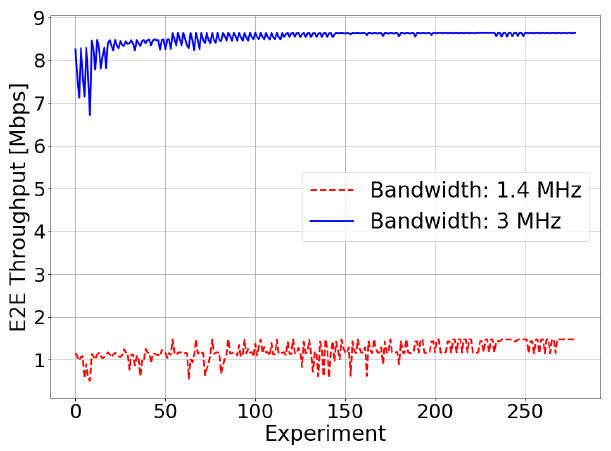
Figure 8. Simulated scenario—E2E throughput